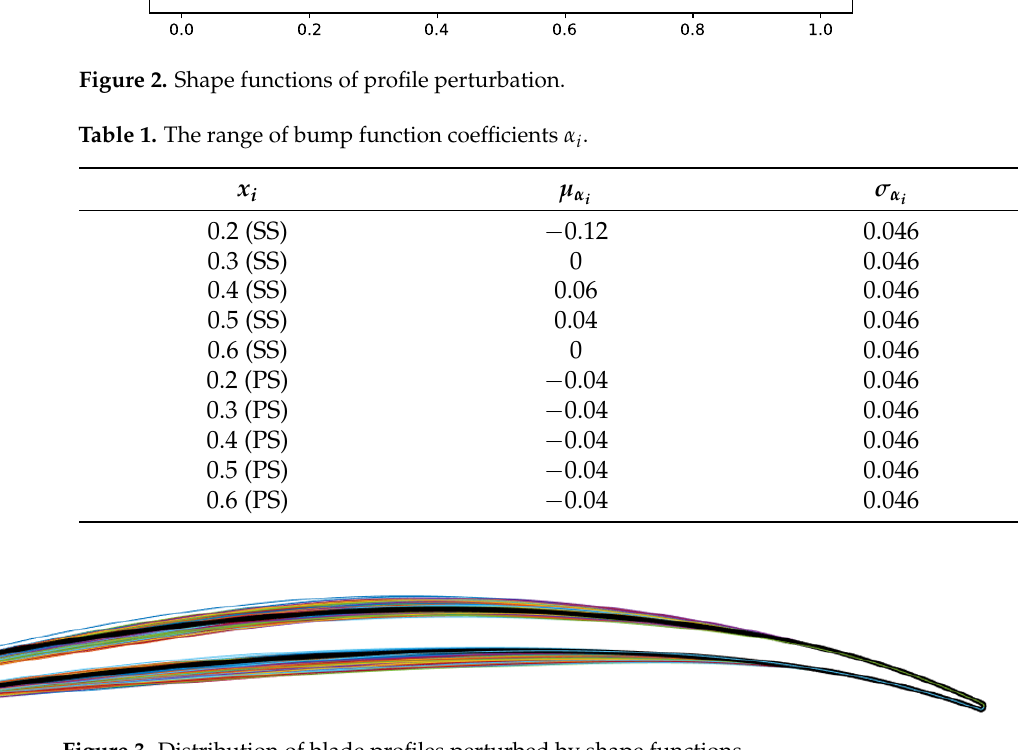
Figure 3. Distribution of blade profiles perturbed by shape